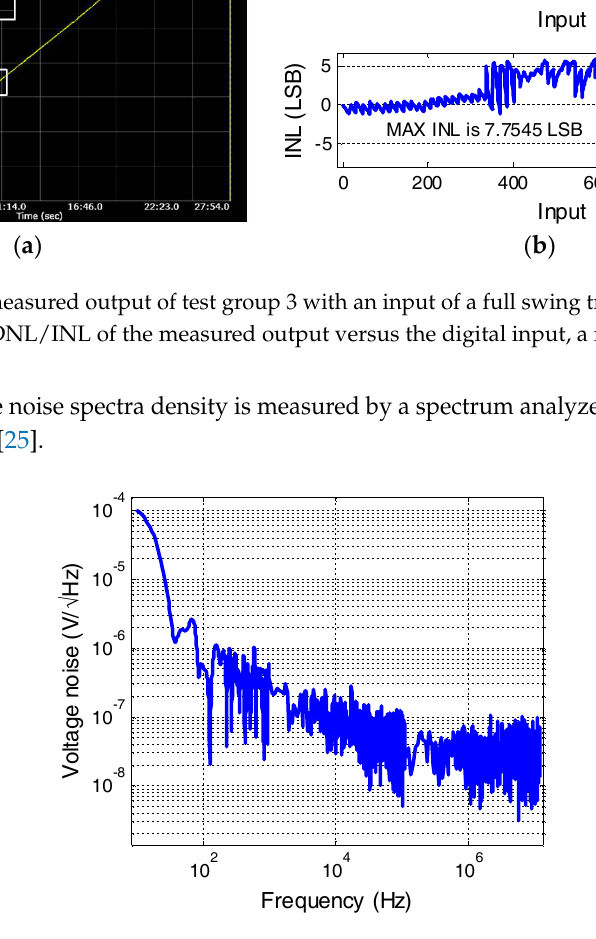
Table 2. The different sizes of resistors and current-source results in different measured nonlinearities.